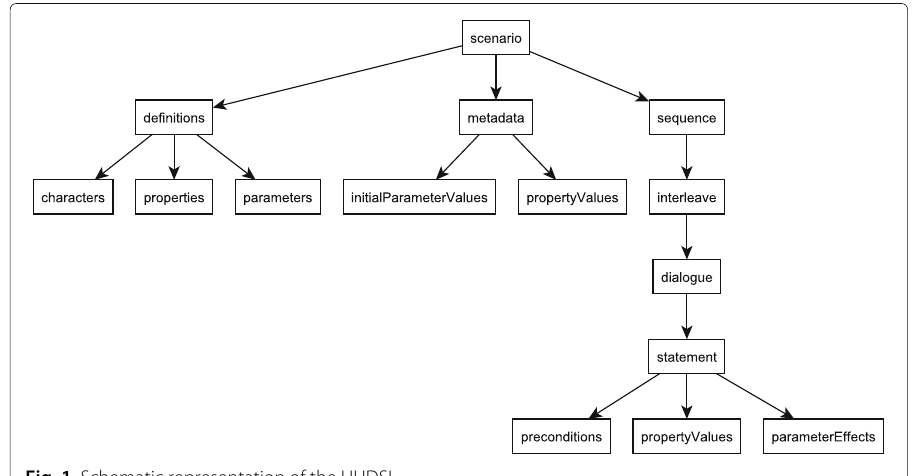
Fig. 1 Schematic representation of the